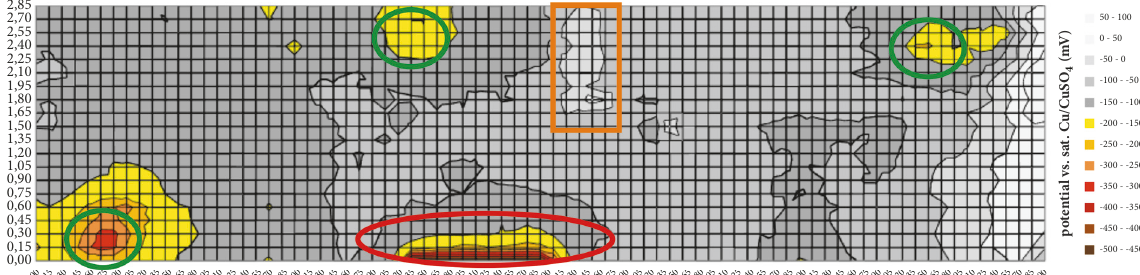
Figure 8: Potential mapping results of the large-scale specimen—three anodes, the galvanized stairway, and an epoxy coated area.